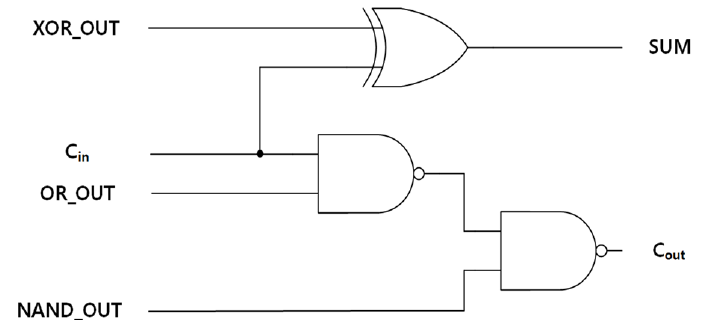
Figure 3. Additional gates for the proposed IMC full adder.